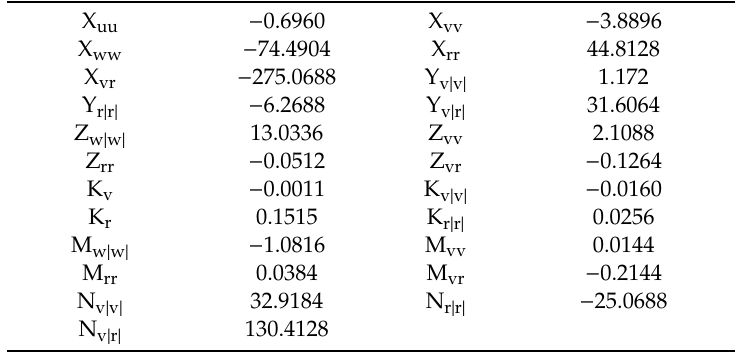
Table 11. Coupling derivatives of the manipulator in viscous